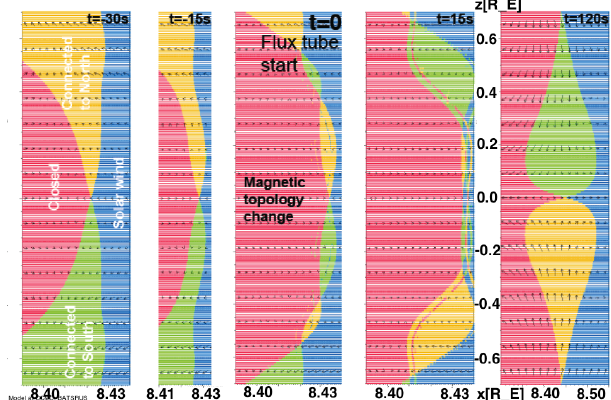
Fig. 8. Magnetic topology for the y - z plane at x = 8 . 41 R E , looking anti-sunward, for different time instants: t = − 30, − 15, 0, + 15s, considering t = 0 as the time when the magnetic topology changes (interlinked flux tubes onset). Colors are related to the magnetic topology as red, closed; yellow, connected to north; green, con- nected to south; and blue, solar wind. Arrows indicate flow velocity. The black line indicates the single and tilted X line before the inter- linked flux tubes onset.